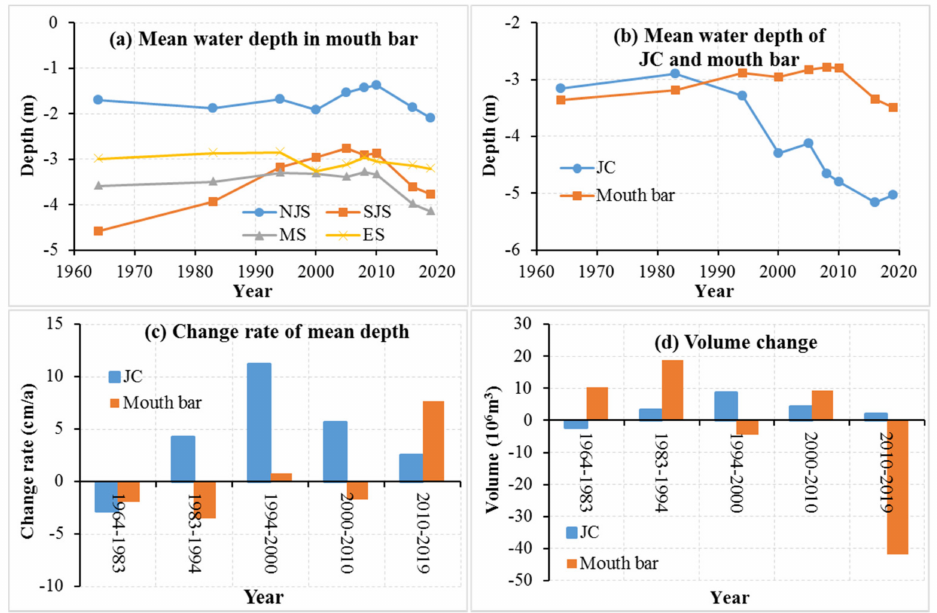
Figure 5. Mean depth and volume of the computed areas from 1964 to 2019. ( a ) mean water depth in the mouth bar, ( b ) mean water depth of JC and mouth bar, ( c ) change rate of mean depth; ( d ) Volume change of JC and mouth